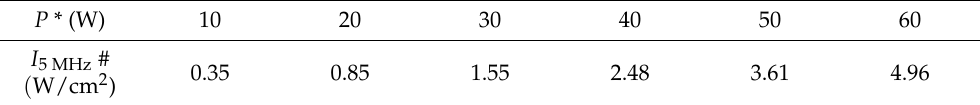
Table 2. Acoustic intensity of 5 MHz HIFU at different electric